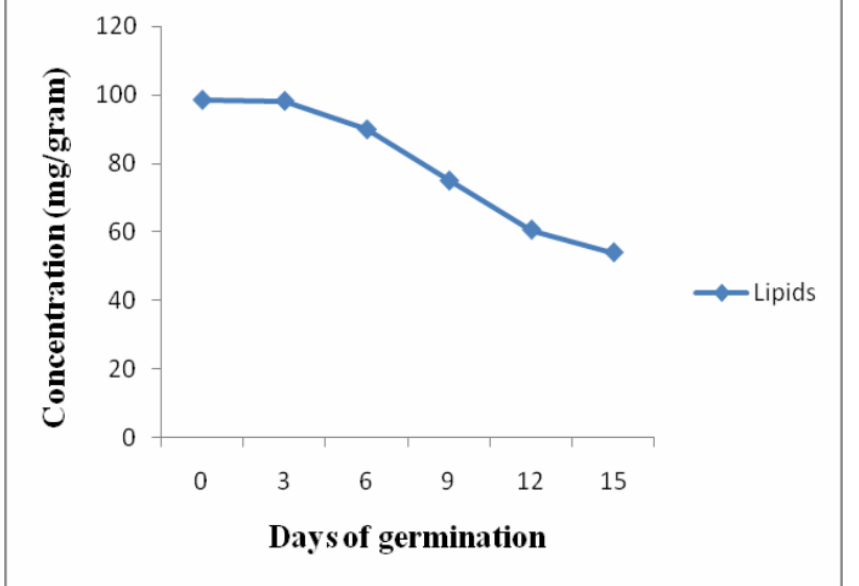
Fig. 2. Total lipid content during seed germination (0-15